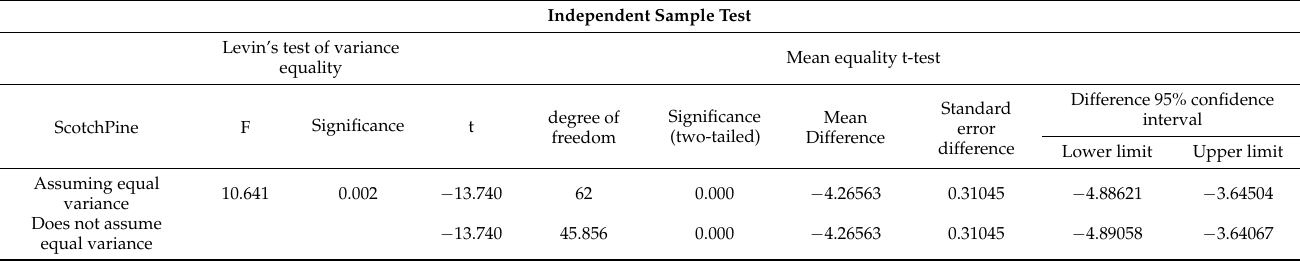
Table 2. Scotch pine’s t -test analysis for adhesives. (Independent sample